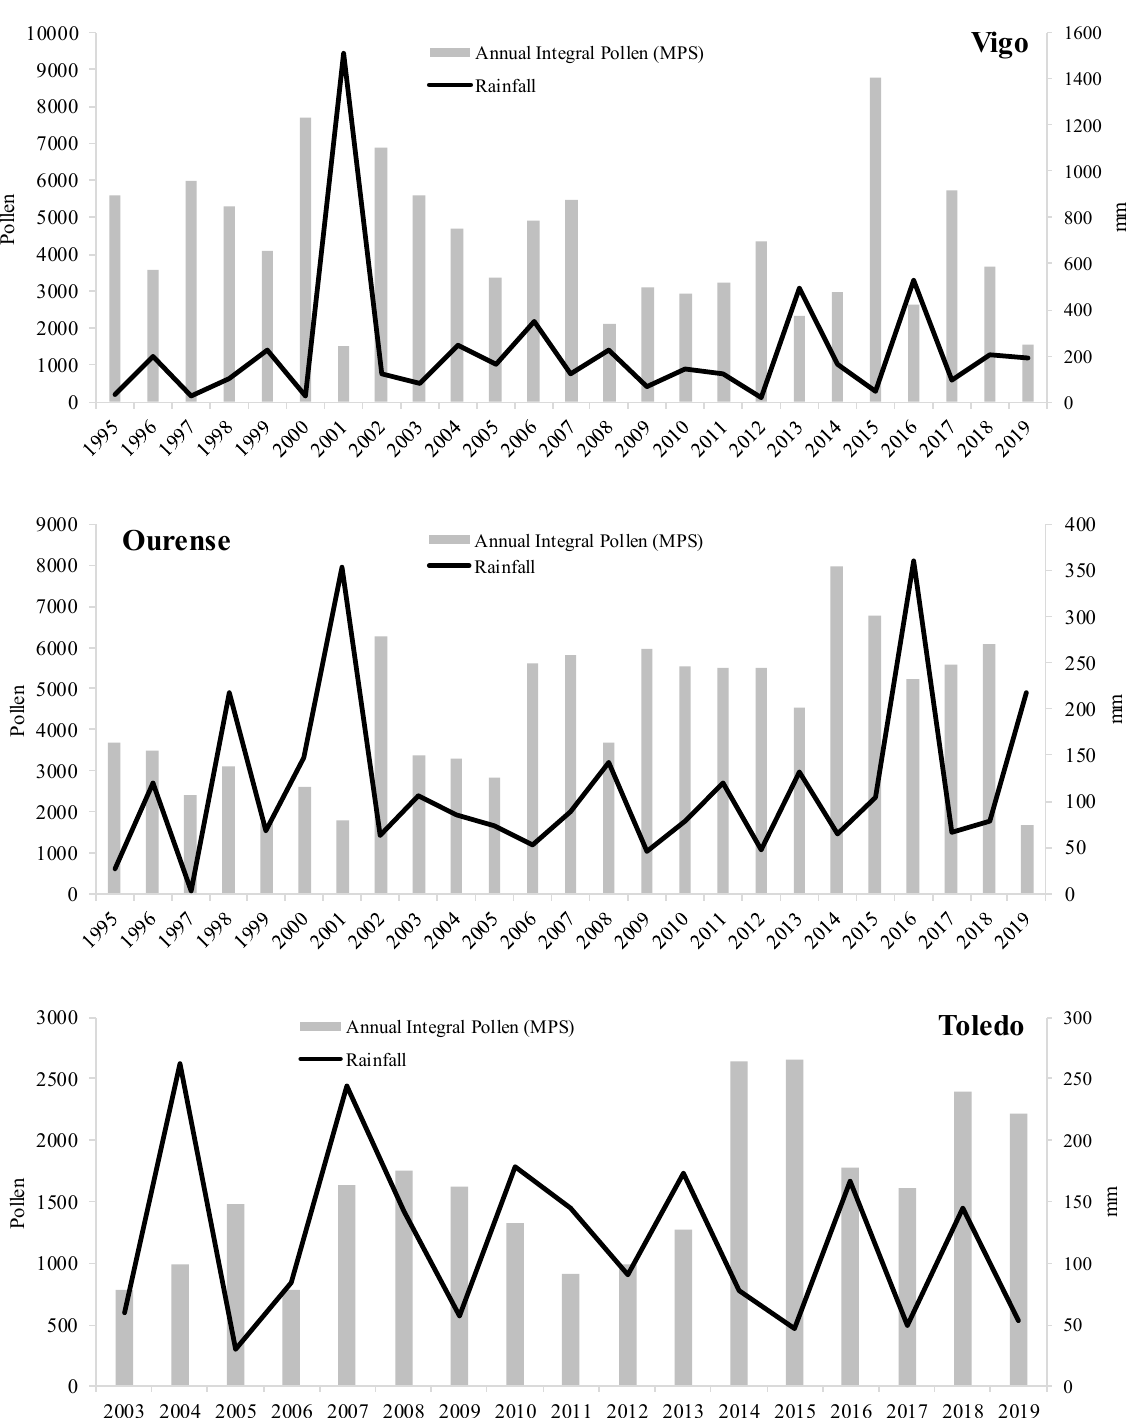
Figure 5. The relationship between airborne Pinus pollen and rainfall during the main pollen season (MPS) of all study years in each study area.